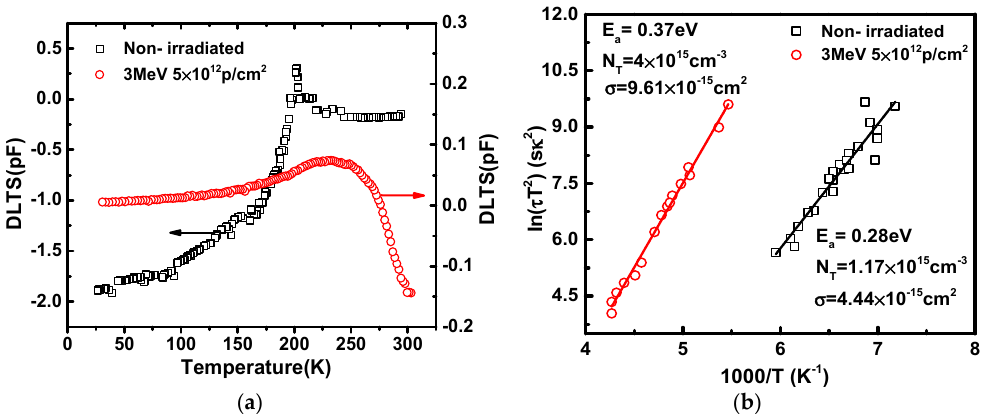
Figure 4. The measurement results before and after 3 MeV proton irradiation in InP/InGaAs heterostructures. ( a ) DLTS spectra and ( b ) The Arrhenius plot for deep level traps.